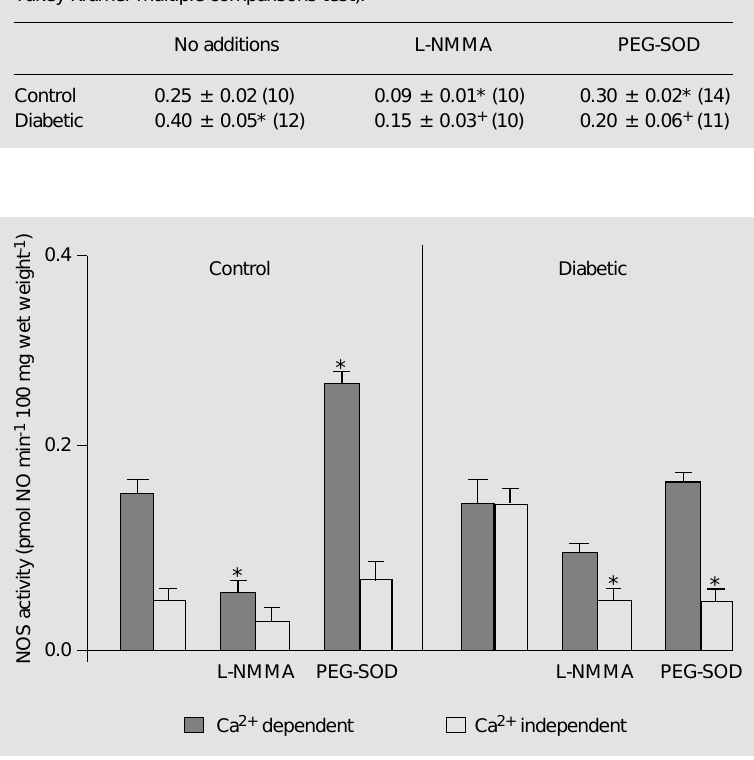
Table 1 - Nitric oxide synthase (NOS) activity: influence of ROS removal. NOS activity in pmol NO min -1 100 mg wet weight -1 in isolated control and diabetic rat pancreas incubated alone or in the presence of 600 µM L-NMMA or 1 U/ml PEG-SOD. Results are reported as means ± SEM. The number of animals is given in parentheses. *P<0.05 vs control (no additions). + P<0.05 vs diabetic (no additions) (ANOVA and Tukey-Kramer multiple comparisons test).